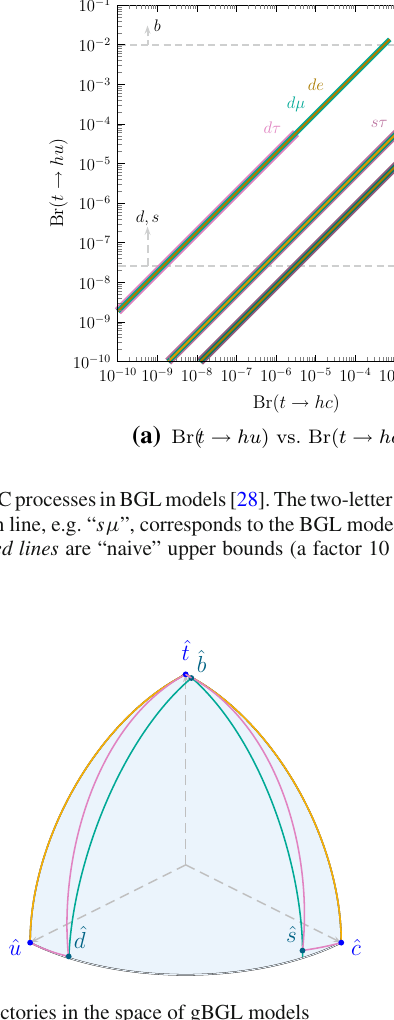
along that ˆ t ↔ ˆ s line, something that cannot occur in any BGL model. The different lines in Fig. 4, as indicated in the figure, correspond to the different correlations associated to the lines in the space of models in Fig.